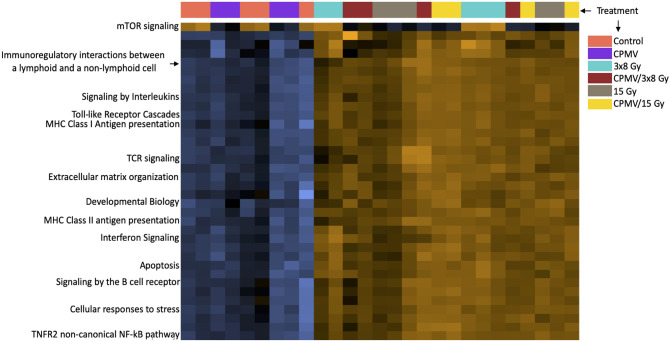
Heatmap of Pathway Expression. Pathway scores are derived from the first principal component of the genes in that pathways normalized expression, and range from -7.7 to 4.5. The NanoString analysis performs a Z-transformation to allow for scores to be displayed on the same scale, with yellow demonstrating high scores with blue demonstrating low scores. (i.e., yellow corresponds to most genes having higher expression in that pathway). The heatmap functions as a simplified way of seeing how treatment cohorts affect pathways differently, with each column representing an animal. While there are many pathways represented, we have labeled the ones we believe to be of importance such as the T cell receptor signaling pathway, antigen presentation pathways, etc. Many of these pathways demonstrate higher expression n scores in the combinatorial groups than either treatment alone. This is a high-level overview depiction of the mRNA results. This information is not appropriate for statistical analysis, as it is meant to be qualitative, not quantitative.